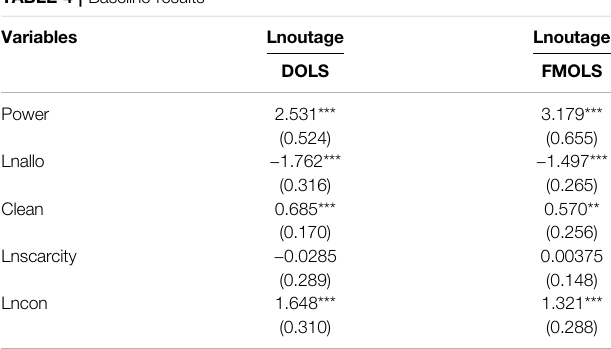
TABLE 4 | Baseline